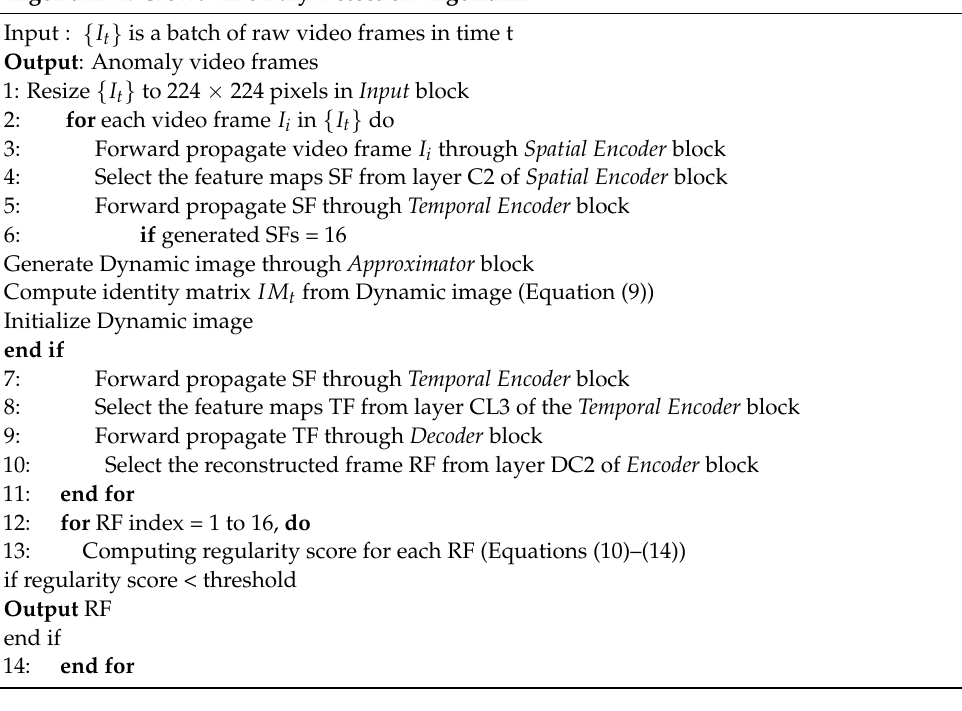
Algorithm 1. Crowd Anomaly Detection